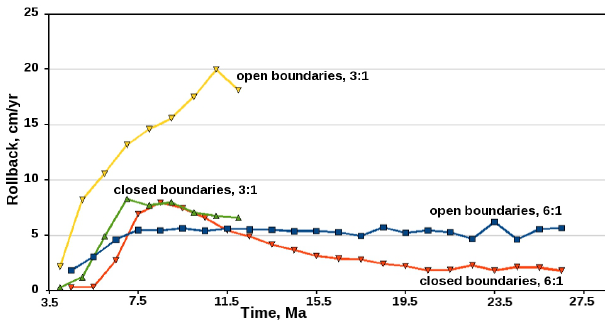
Fig. 7. Speed of rollback for the model with open boundaries and model with closed boundaries: model OO3 (yellow line), model CRCR3 (green line), model OO6 (blue line) and model CRCR6 (red